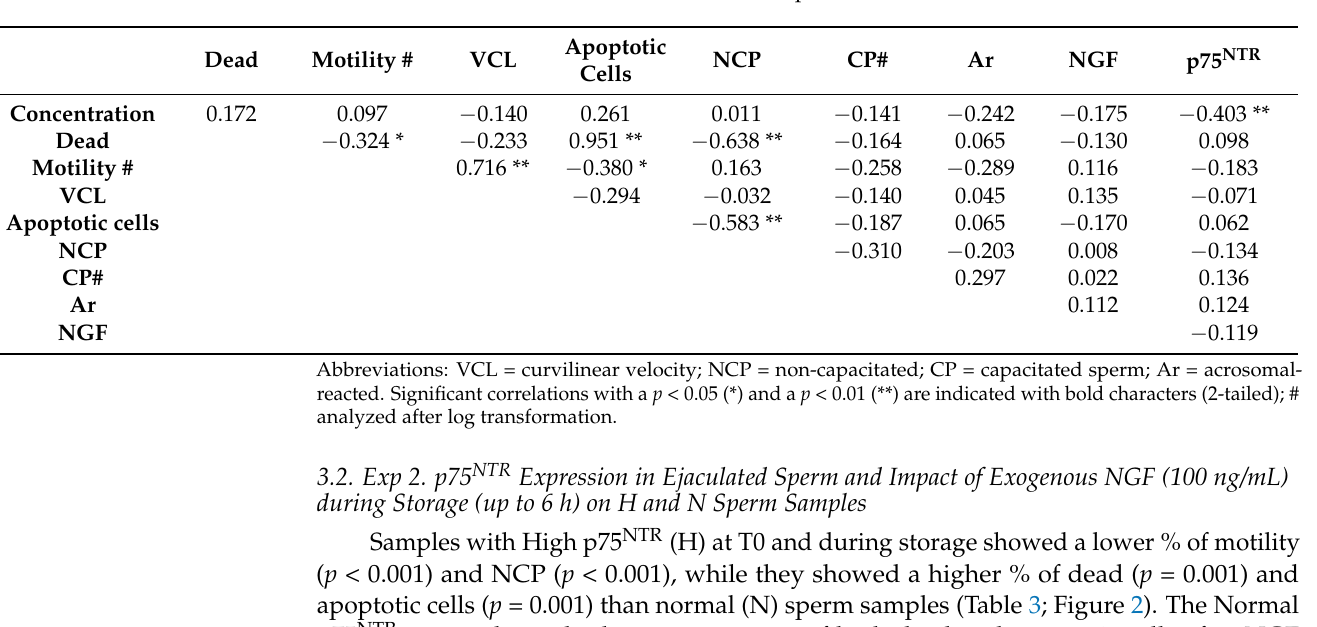
Table 2. Pearson correlation coefficient between parameters evaluated at the time 0.